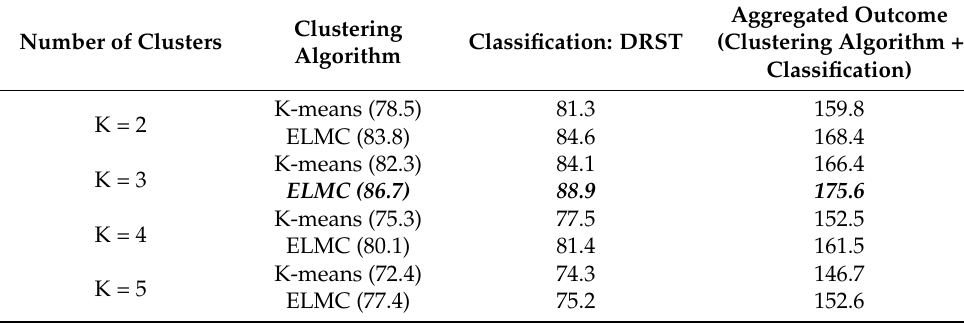
Table 3. The experimental results of two clustering algorithms (avg.